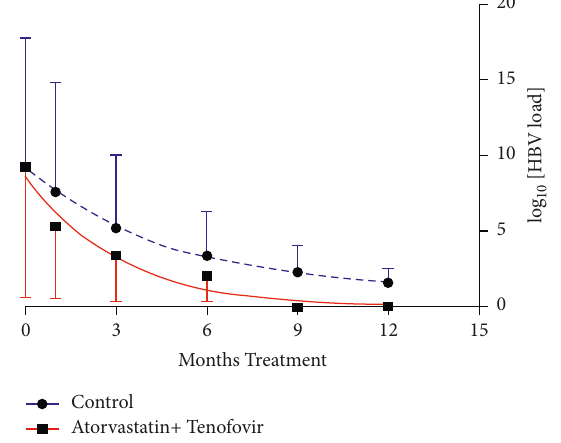
Figure 2: The effect of treatments on viral load. Data are mean+SD of viral load measured at indicated time points in the blood of 20 patients. A nonlinear curve was fitted to each set of data, from which the half-life of viral load in the plasma could be